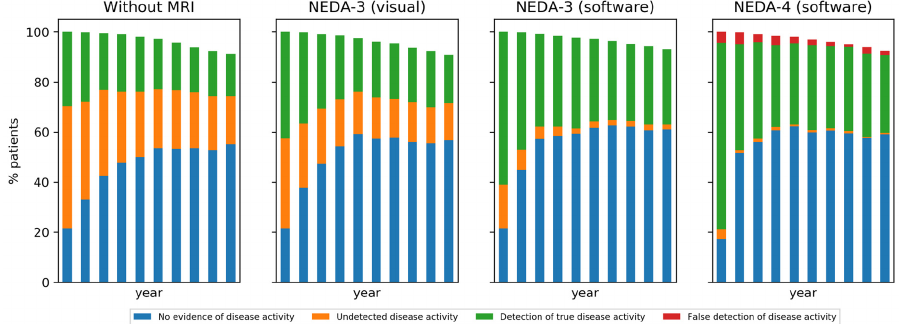
Figure 4. Comparison of decision-making strategies in terms of the proportion of patients in each model state according to the decision-making state transition model in Figure 2. Patients who reached EDSS 7 and are no longer on DMT are excluded.